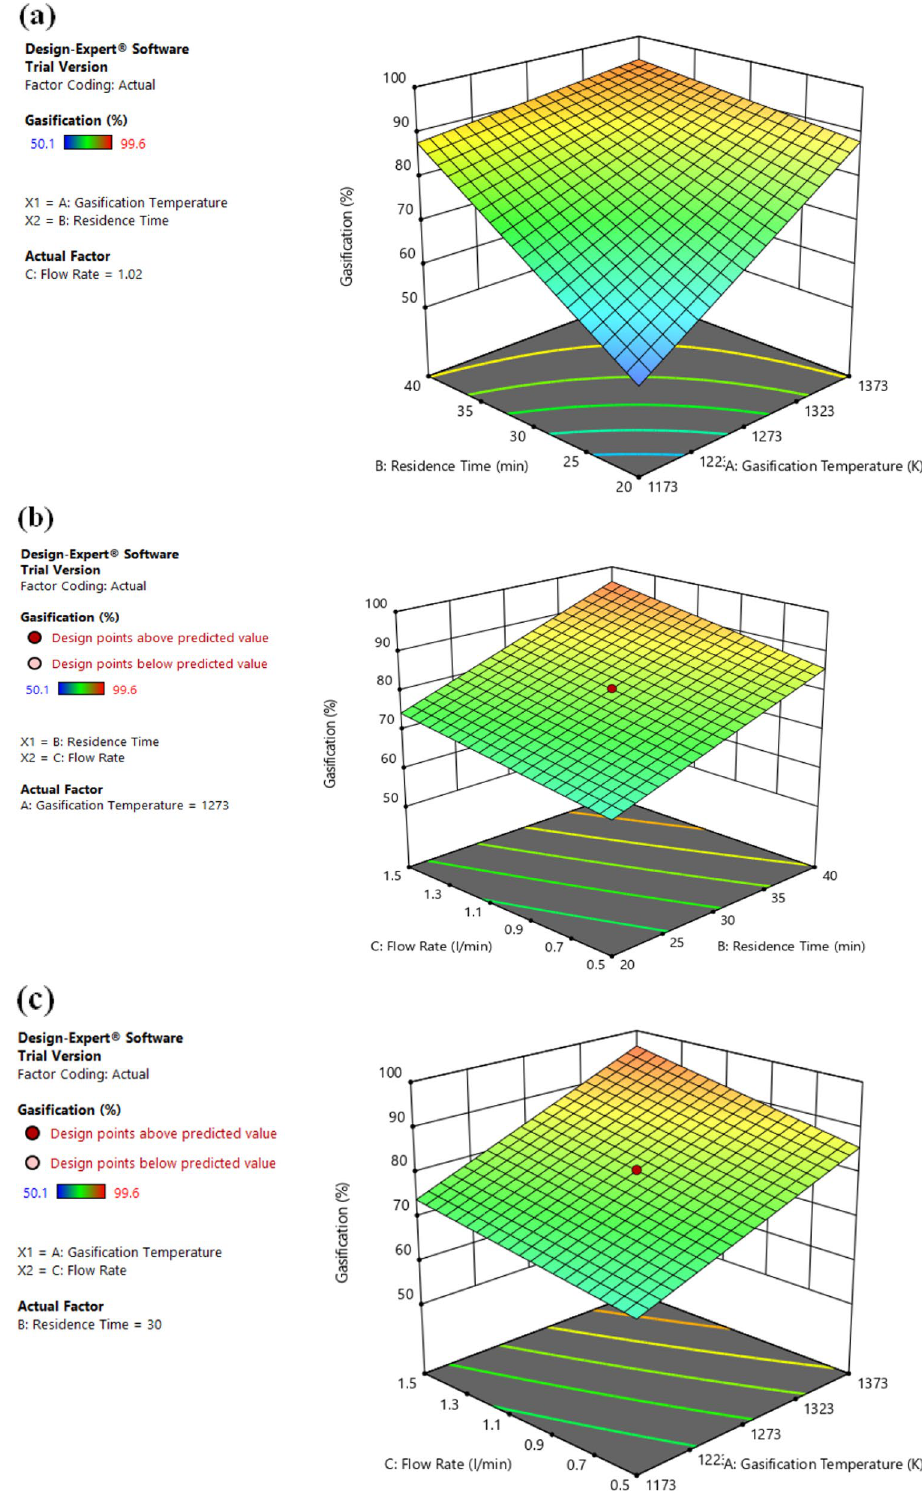
Fig. 9 3-D surface plot of LVWC-I gasification versus a Residence time and gasification temperature b Flow rate and residence time and c Flow rate and gasification